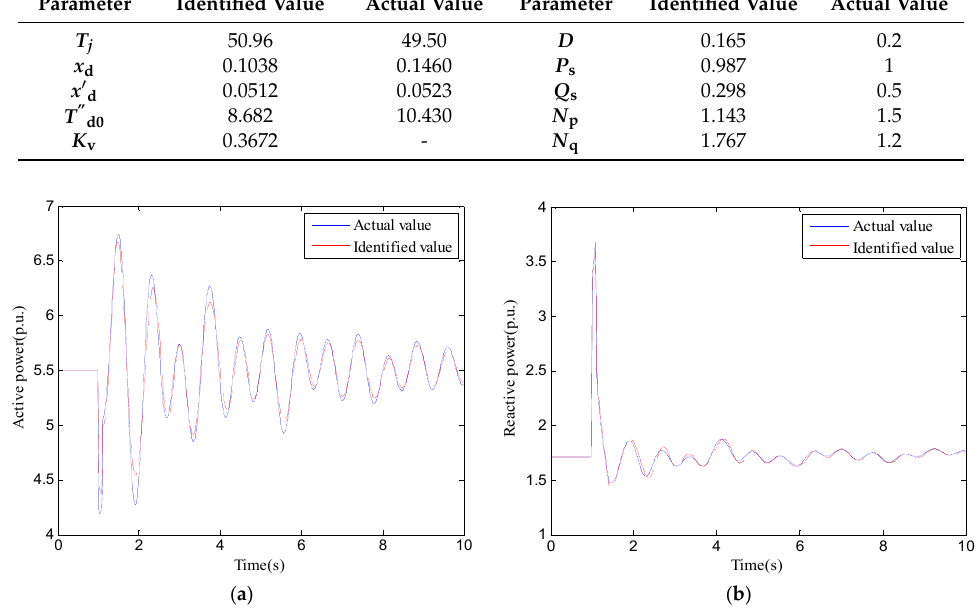
Figure 6. ( a ) Active power curves based on identified parameters and actual parameters; ( b ) reactive power curves based on identified parameters and actual parameters.